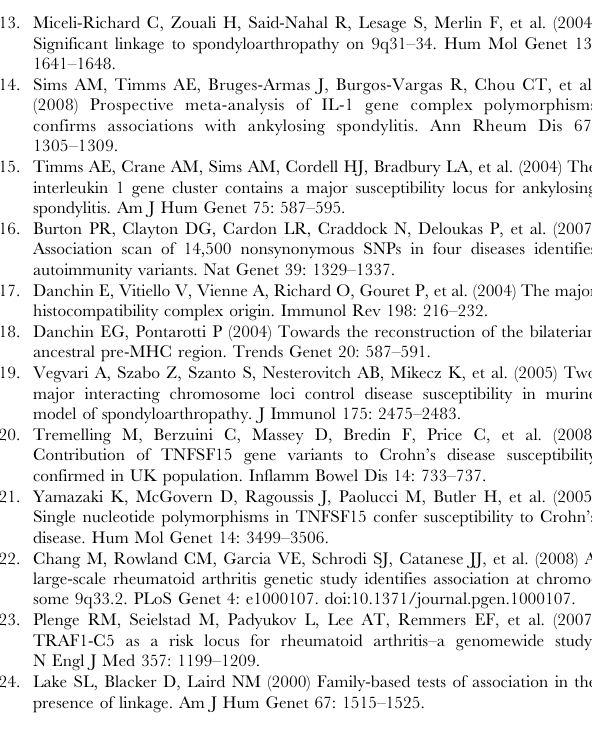
Table S3 Complete results of case/control association extension study (TaqMan genotyping - 139 SpA cases/163 healthy controls).